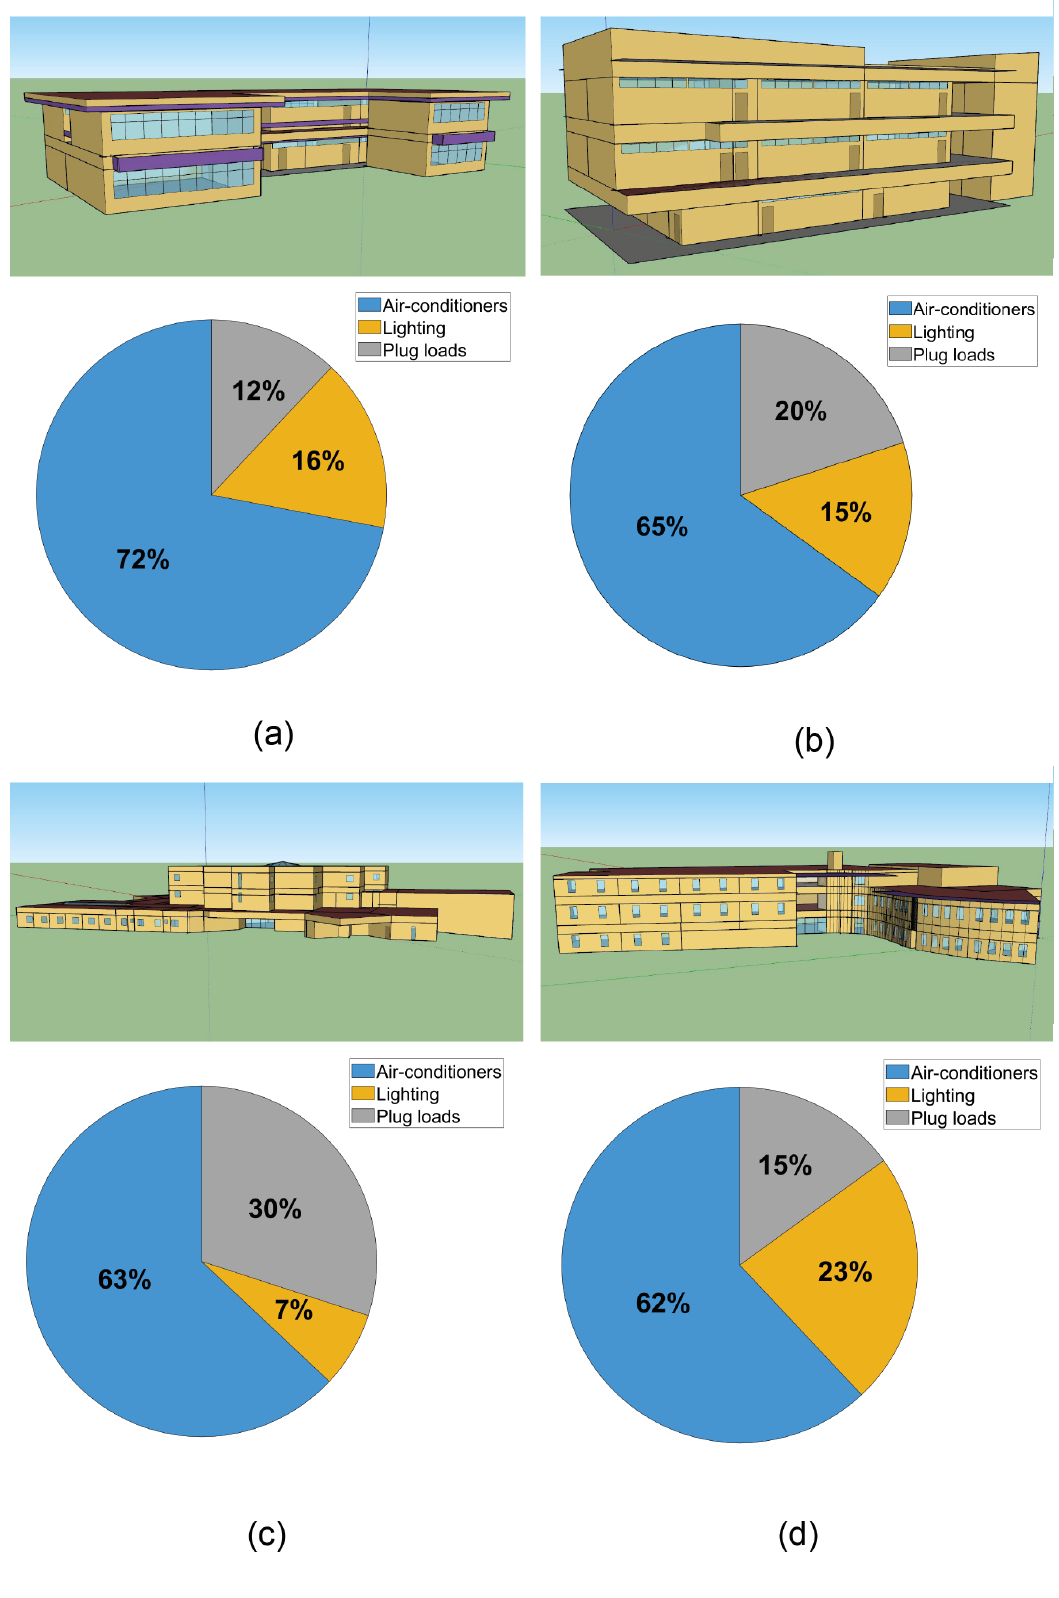
Figure 6. Energy models and estimated annual share of energy by end-use: ( a ) Building 1, ( b ) Building 2, ( c ) Building 3, and ( d ) Building